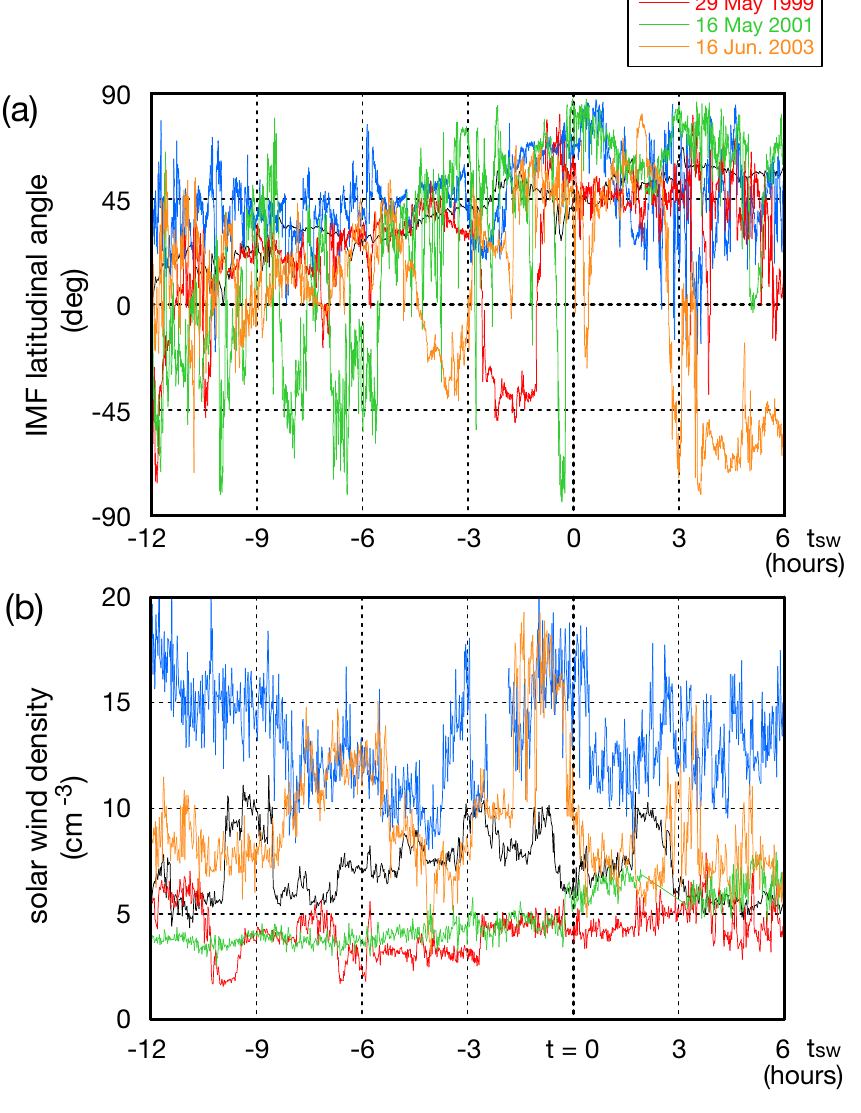
Fig. 11. Superposed plots of the solar wind parameters for the 5 events. The upper panel (a) shows the latitudinal angle of the IMF, and the lower one (b) does the density of the solar wind protons. The zero of the horizontal axis ( t SW ) corresponds to the emergence of the two-component